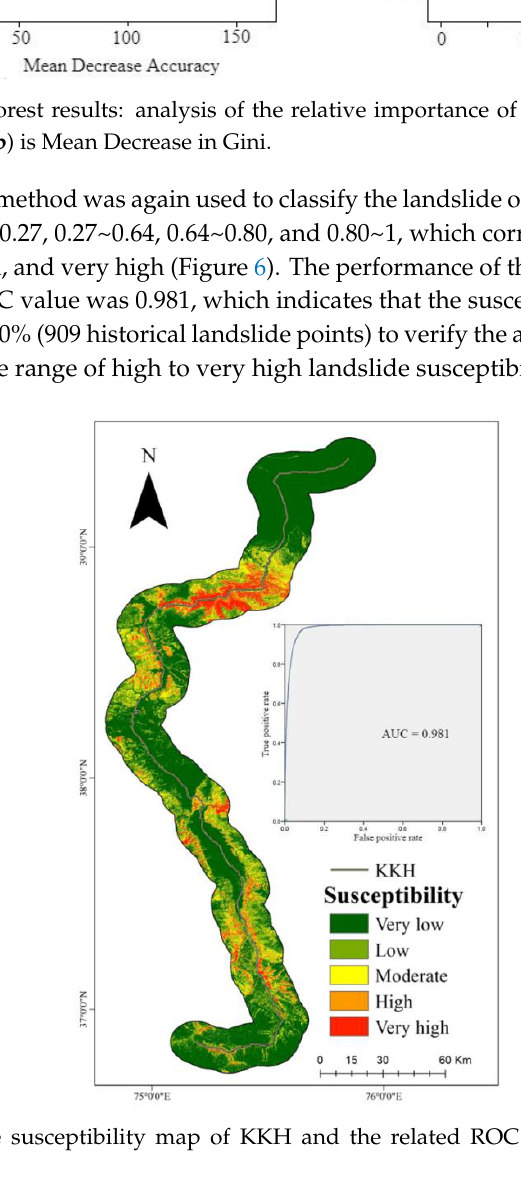
Figure 5. Random forest results: analysis of the relative importance of the variables. ( a ) is Mean Decrease Accuracy, ( b ) is Mean Decrease in Gini.